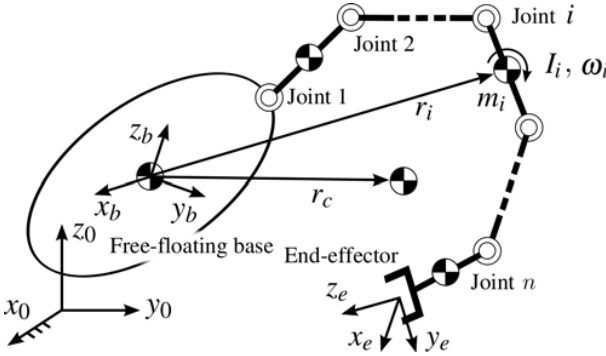
Figure 1. Model of a free-floating base serial-link